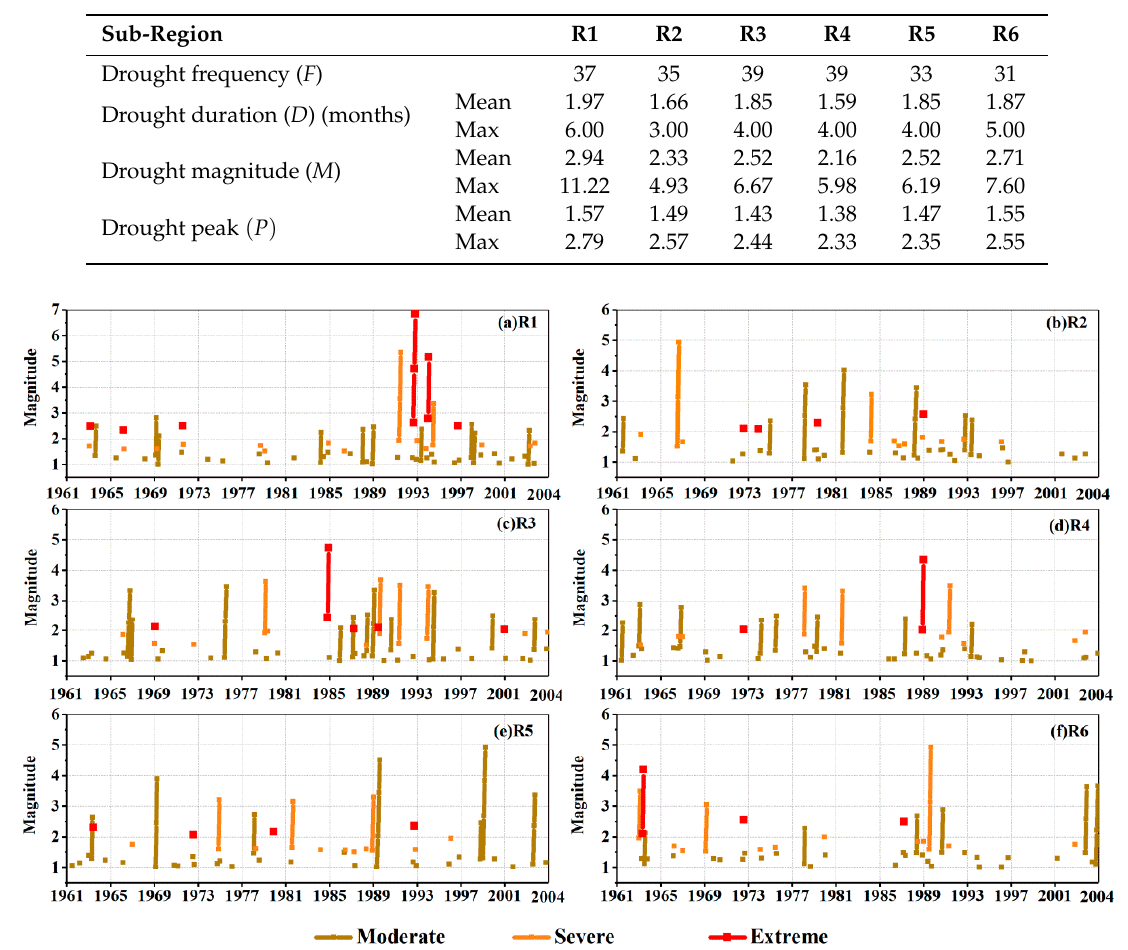
Figure 6. Temporal evolution of drought magnitude for the selected events of moderate, severe, and extreme droughts in six sub-regions. Table 2. Identified drought characteristics for the six sub-regions.